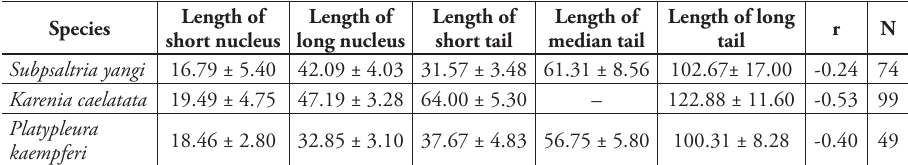
Table 3. Modal classes and correlation coefficients (r) of nucleus length (mean ± SE μm) vs tail length (mean ± SE μm) in the spermatozoa of three cicada species. Length of Length of Length of Species short nucleus long nucleus short